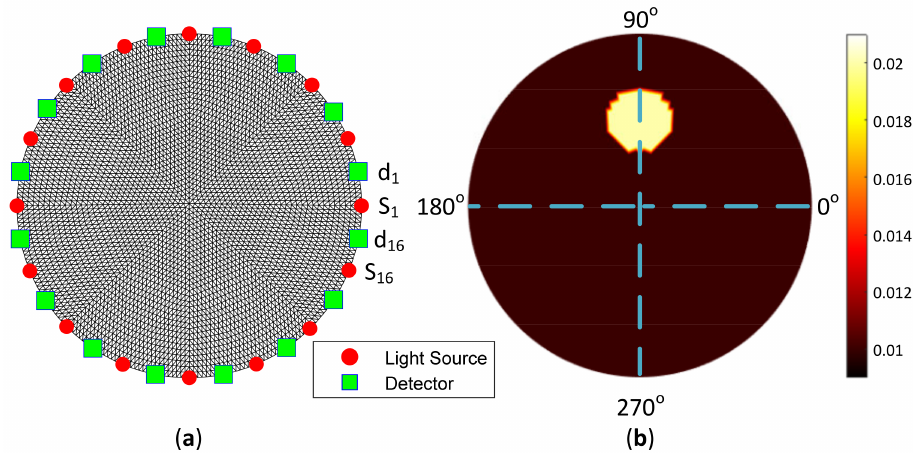
Figure 6. Model geometry showing ( a ) light sources (red dot) and detectors (green rectangle) where S n is the n -th sensor and d n denotes the n -th detector, as well as ( b ) artificial embedded inclusion position inside the